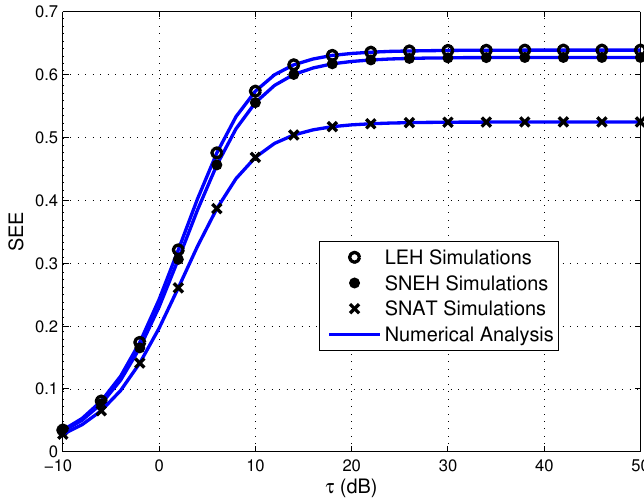
Figure 10. Secure energy efficiency versus τ in three EH modes, where Γ th _ S = 3